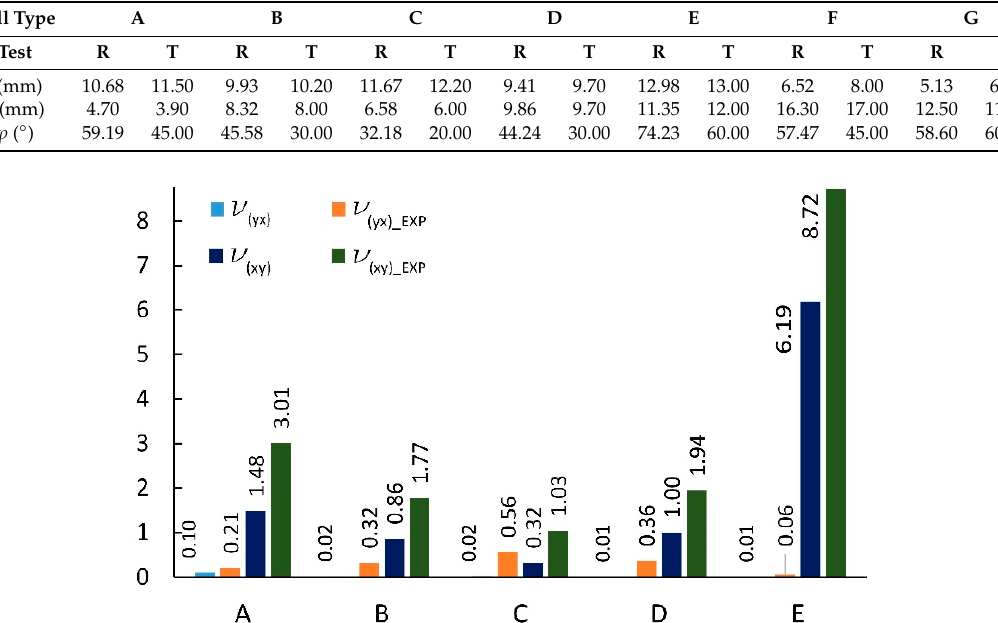
Figure 10. Poisson’s ratio for cells of the type: F, G (EXP-experimental research). Figure 11. Modulus of linear elasticity for cells of the type: F, G (EXP-experimental research). The main reason for these discrepancies is the assumptions based on which the relevant mathematical models were built [54]. These assumptions idealized the shape and dimensions of the cell walls, as well as the shape and dimensions of the cells themselves. They did not take into account geometric imperfections and the resulting weakening of the stiffness of structures subjected to axial compression. For this reason, later in the work, it was decided that the results of experimental studies would be compared with the results of numerical calculations for all types of cells made of unimpregnated and impregnated papers. Achieving compliance of these results confirms the